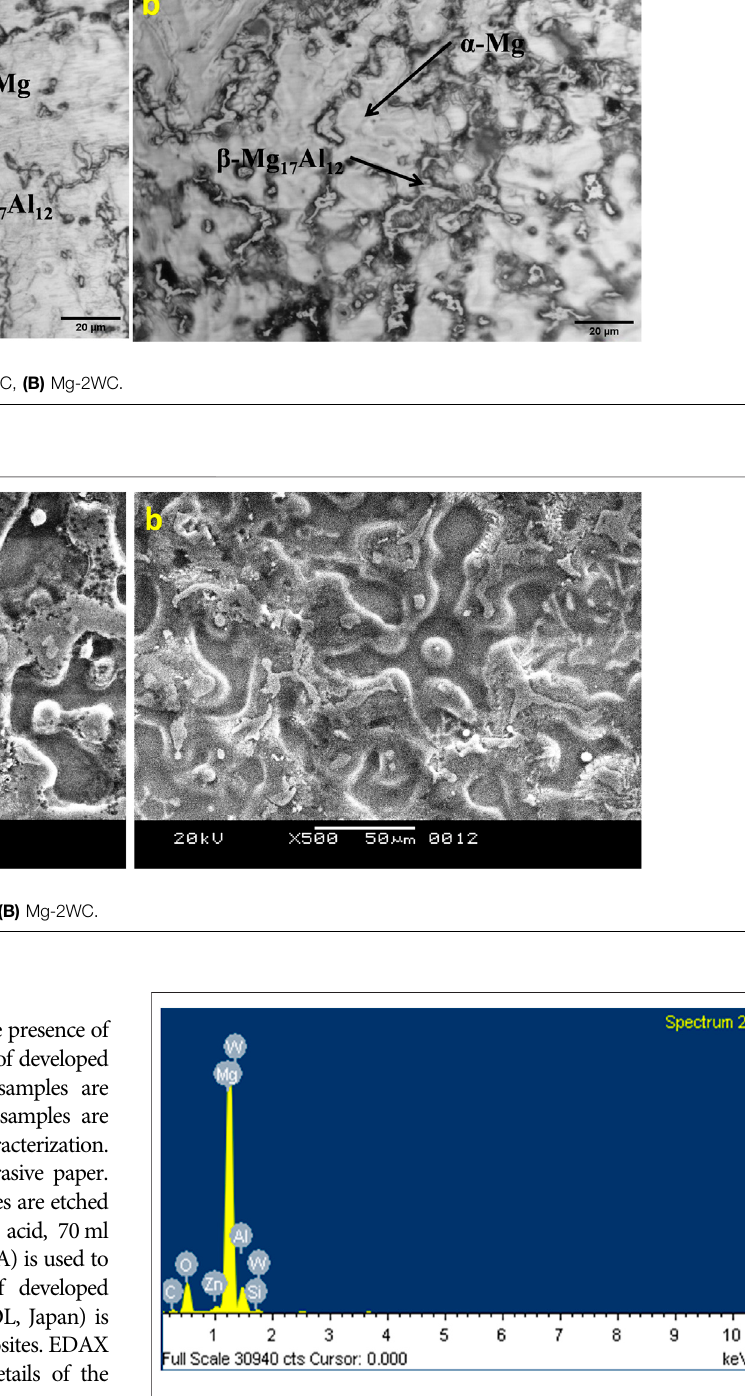
FIGURE 5 | EDAX spectrum of Mg-2WC